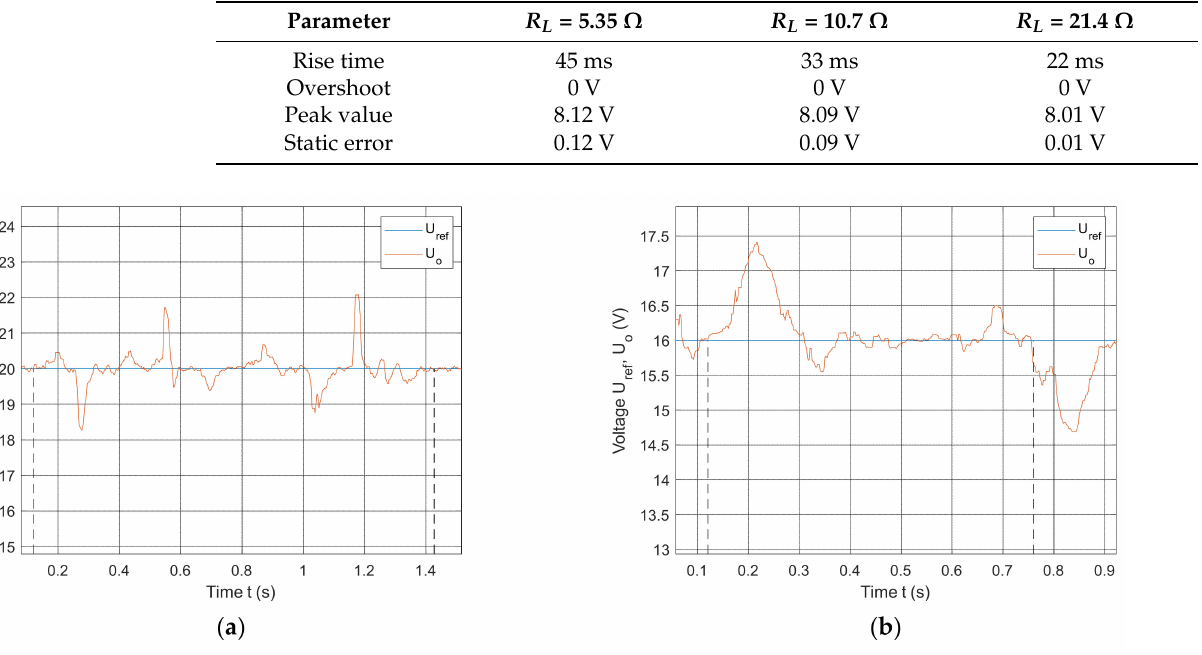
Figure 14. Closed-loop controller response to change in mutual inductance. ( a ) Horizontal movement and misalignment, ( b ) vertical movement between 15 mm and 30